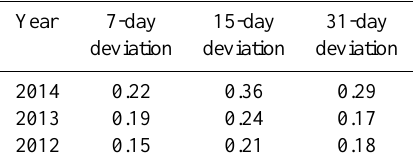
Table 4. Top soil layer temporal correlation statistics between spa- tially weighted daily in situ data and ESA CCI soil moisture anoma-